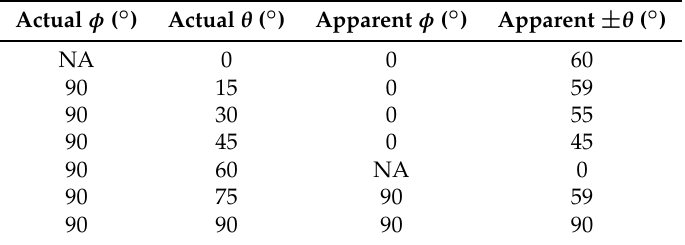
Table 1. Actual vs. apparent angles using standard method for Figure 2 (left to right).